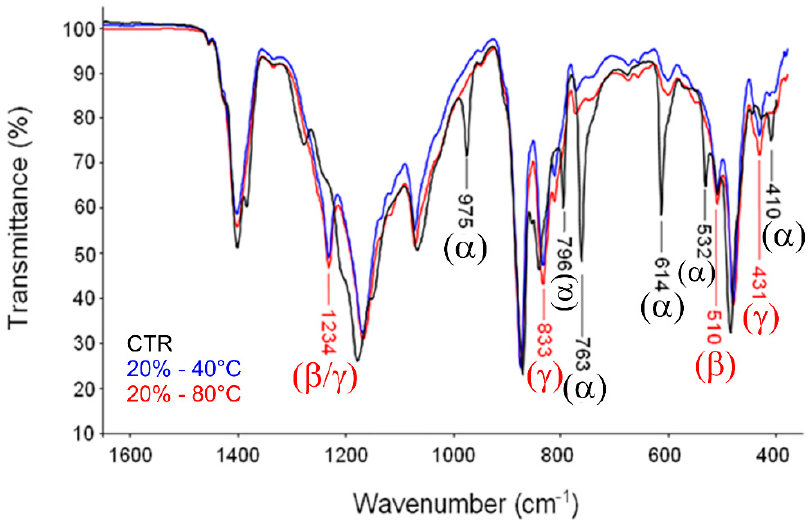
Figure 5. ATR spectra of PVDF films (20%) casted under different temperature conditions (40–80 °C). CTR refers to neat PVDF pellets used as control.